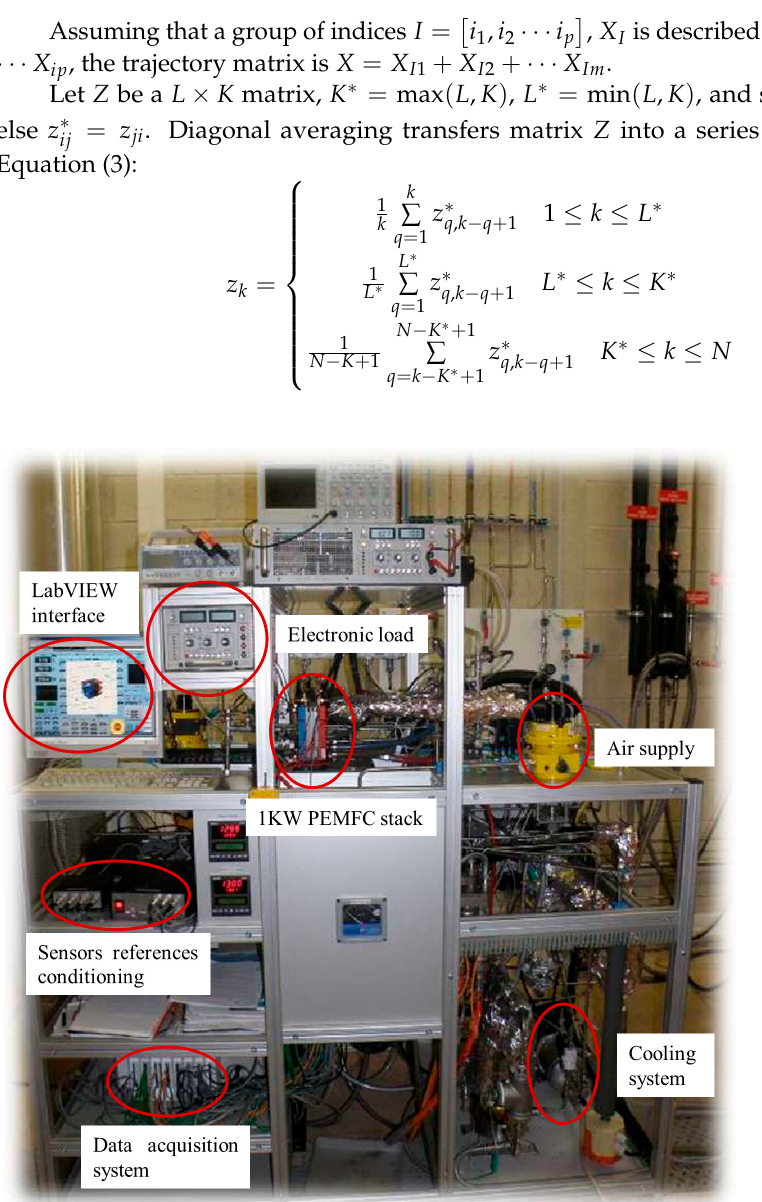
Figure 1. PEMFC system experimental platform [34].